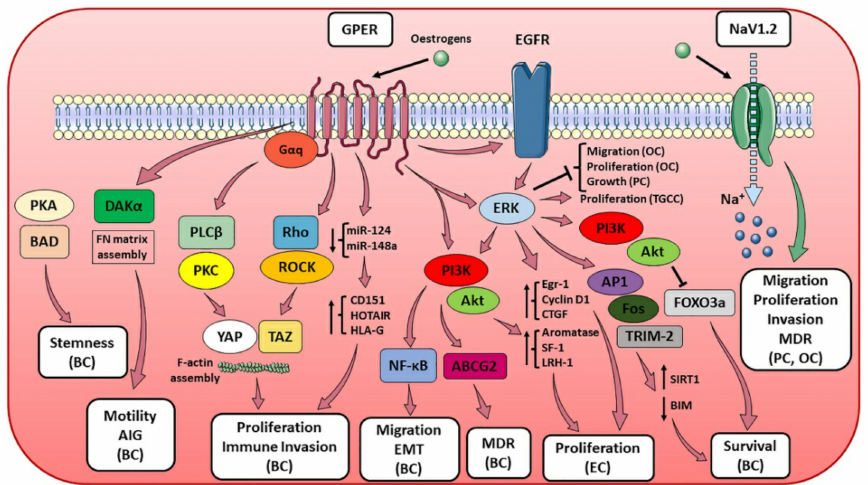
Figure 2. mER-associated pathways and their effect on hormone-sensitive cancer progression. The figure illustrates the molecular pathways correlated to the different mERs and their biological effects on multiple hormone-sensitive cancer types. When one or more tumor-related processes were reported only for a specific cancer type, the latter was made explicit in the figure and put in parentheses (e.g., breast cancer as BC, prostate cancer as PC, endometrial cancer as EC, ovarian cancer as OC and testicular germ cell cancer as TGCC). Other abbreviations: multi-drug resistance (MDR), anchorage-independent growth (AIG) (see text for